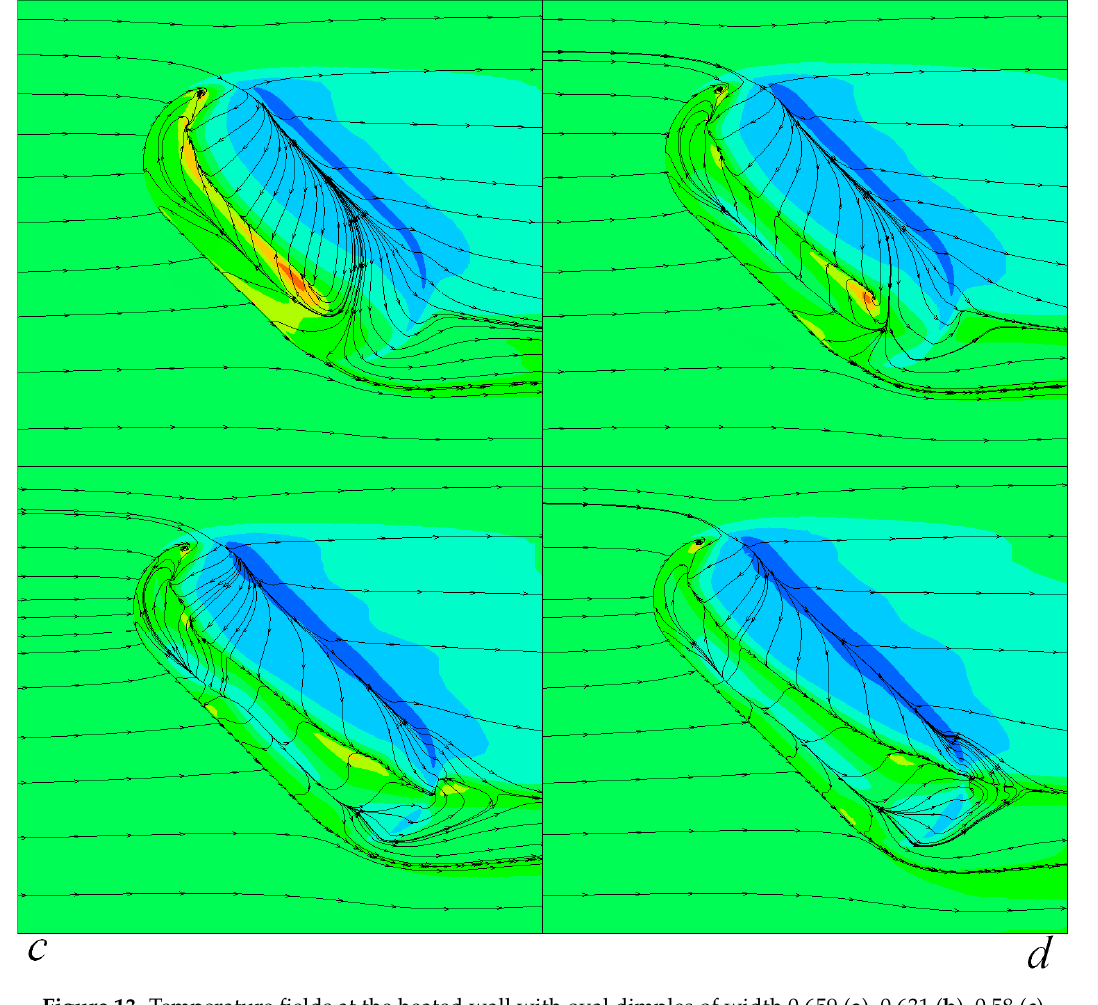
Figure 13. Temperature fields at the heated wall with oval dimples of width 0.659 ( a ), 0.631 ( b ), 0.58 ( c ) and 0.549 ( d ) and the streamlines.